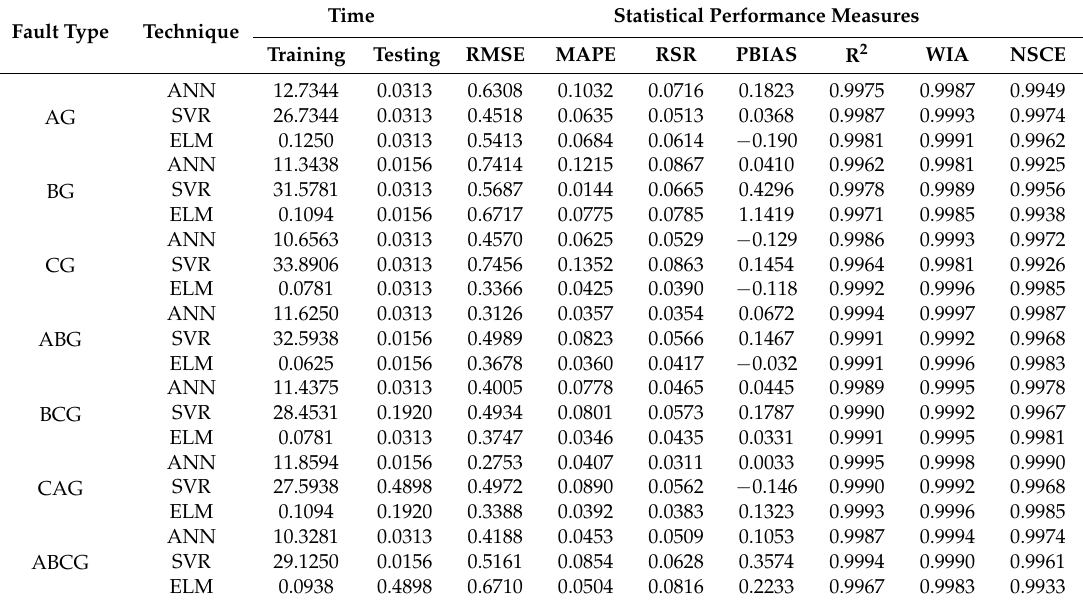
Table 8. Operation time and the statistical performance indices, for the test datasets with CF-PSO optimized MLT, in the presence of 20 dB